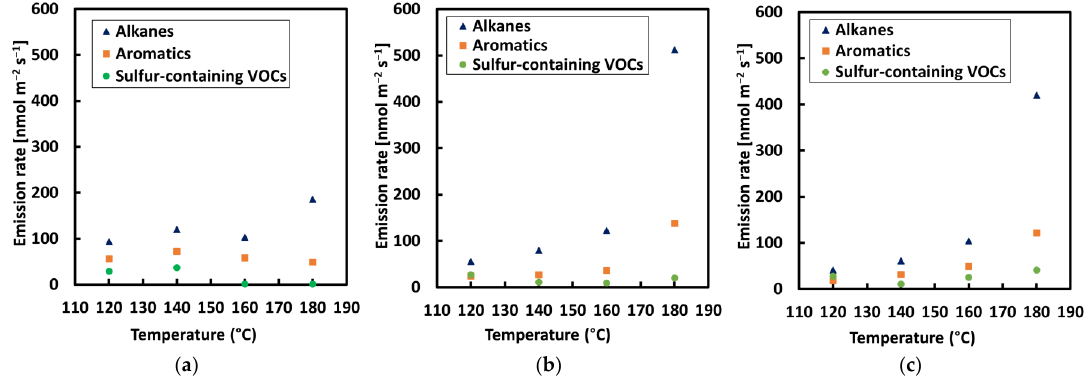
Figure 4. VOC concentration rate of alkanes, aromatics, and sulfur compounds for each sample with a step-by-step increase in temperature: ( a ) REF, ( b ) crumb rubber modified bitumen 1 (CRMB1), and ( c ) CRMB2.